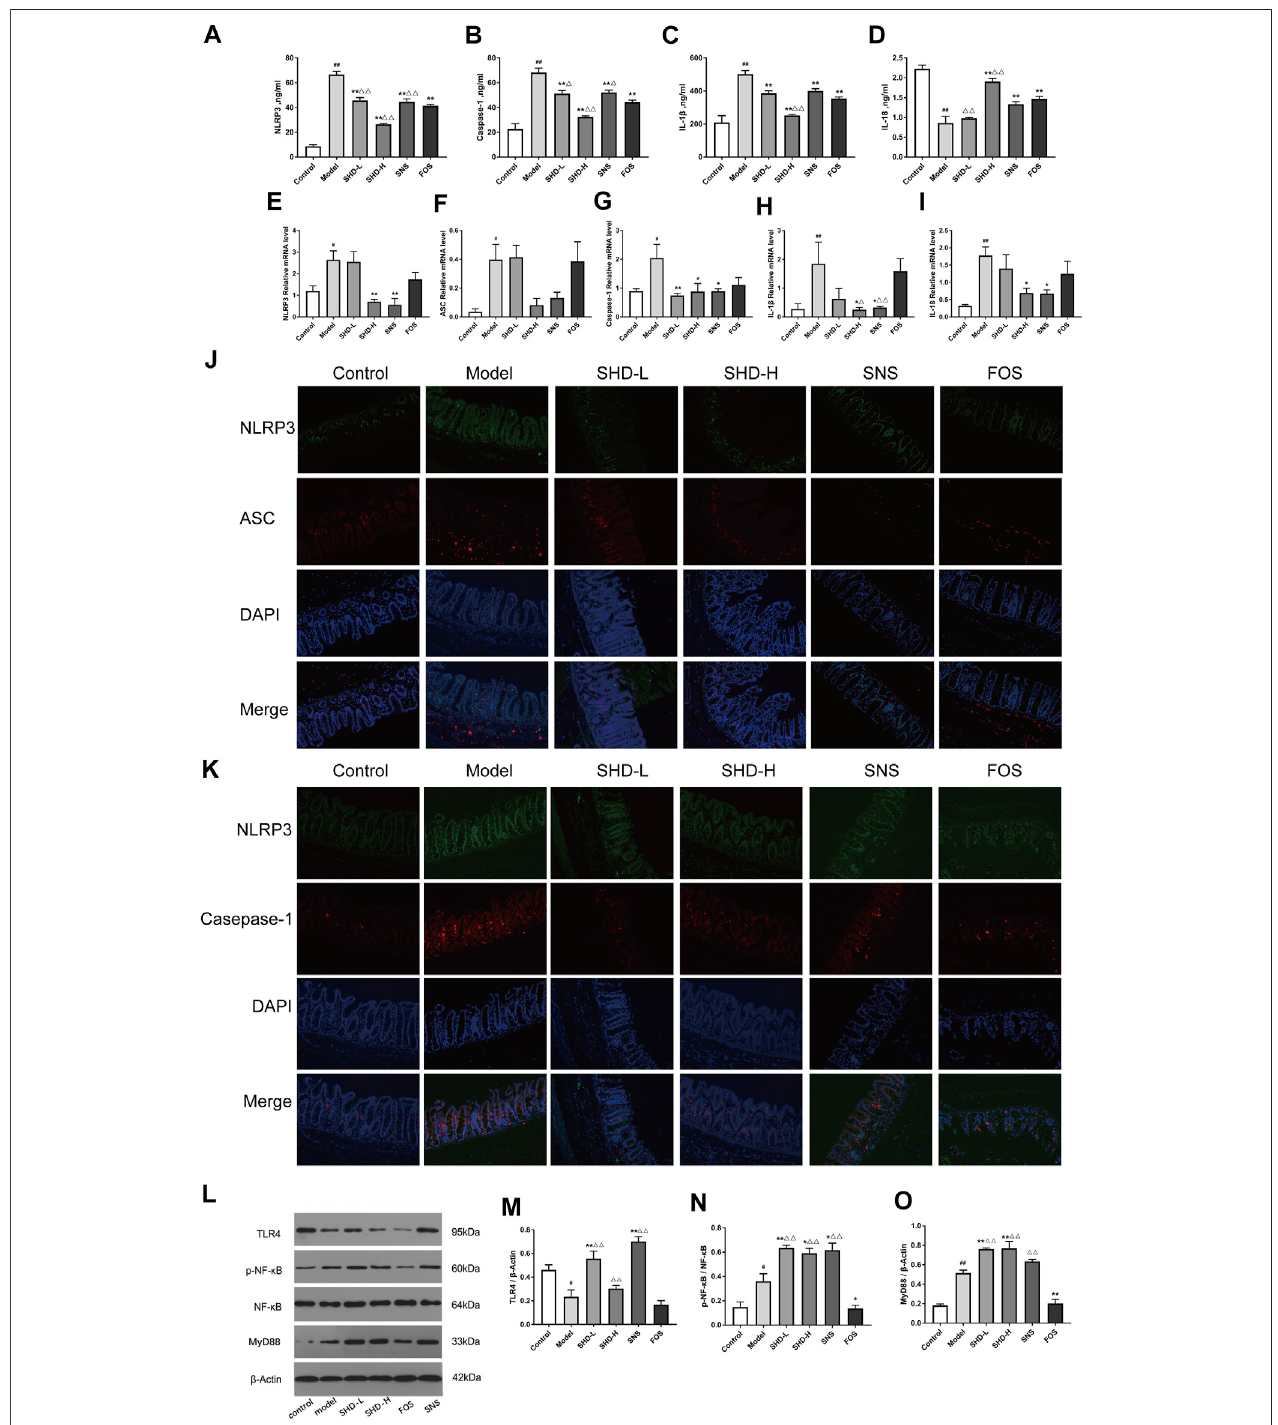
FIGURE 6 | SHD reduces the CUS-induced expression of NOD-like receptor protein 3 (NLRP3), apoptosis-associated speck-like protein containing a CARD domain (ASC), caspase-1, interleukin-1 β (IL-1 β ), and IL-18 in the serum and cecum mucosa and the activation of the Toll-like receptor 4 (TLR4)/nuclear factor (NF)- κ B signaling cascades. (A) Serum levels of NLRP3 in each group. (B) Serum levels ofcaspase-1 in each group. (C) Serum levels of IL-1 β in each group. (D) Serum levels of IL-18 in each group ( n (cid:2) 5). (E) Relative mRNA expression levels of NLRP3 in the cecal tissue. (F) Relative mRNA expression levels of ASC in the cecal tissue. (G) RelativemRNAexpression levelsofcaspase-1inthececaltissue. (H) RelativemRNAexpression levelsofIL-1 β inthececaltissue. (I) RelativemRNAexpressionlevelsof IL-18inthececaltissue.The2 − ΔΔ Ct methodwasusedtoanalyzetherelativegeneexpression( n (cid:2) 4 – 5). (J) PositiveareaexpressionlevelsofNLRP3andASCinthececal